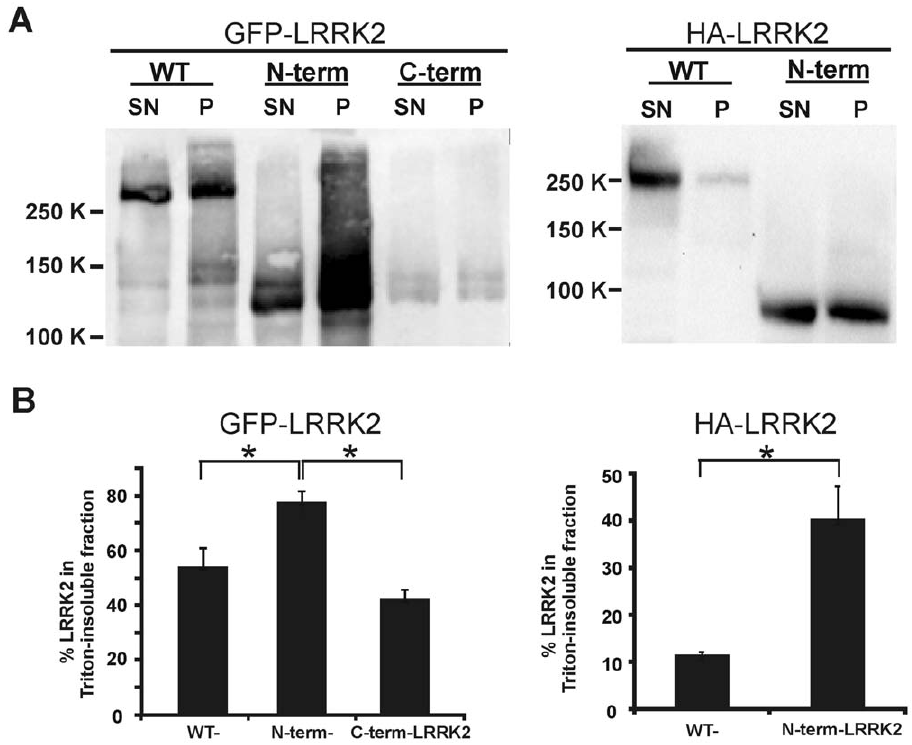
Figure 4. N-term-LRRK2 is more insoluble than WT-LRRK2 in SH-SY5Y cells. SH-SY5Y cells were transfected with EGFP-LRRK2 (WT, N-term, C-term) or HA-LRRK2 (WT, N-term) constructs and harvested 16 h later. Cells were lysed and fractionated as described in the Methods followed by western blot analysis. (A) Representative immunoblots showing LRRK2 bands with anti-HA antibody, SN (supernatant, Triton-soluble fraction), P (pellet, Triton-insoluble fraction). (B) Quantitation of multiple experiments in which the percentage of Triton-insoluble LRRK2 was calculated as Triton- insoluble LRRK2/(Triton-soluble + Triton-insoluble LRRK2) * 100. Data represent the mean 6 SD (*p , 0.05, n=3).